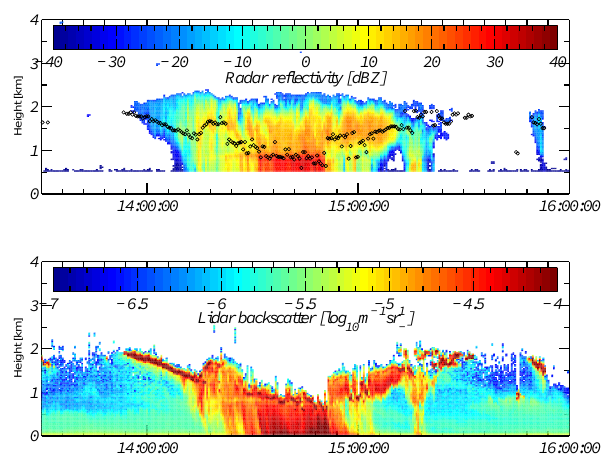
Fig. 2. Time-height contour plot of vertically pointing cloud radar (top panel) and lidar ceilometer (bottom panel) during flight B425. Black markers on the radar time series show the height range of the cloud base detected by the